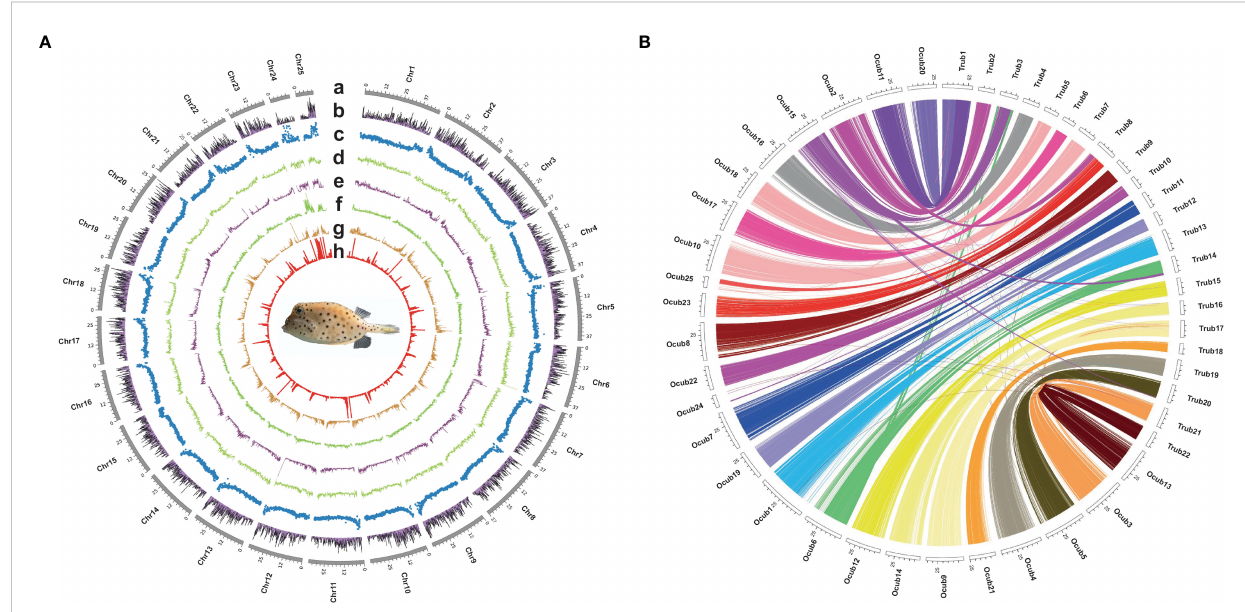
FIGURE 1 Circos plot basic characteristics of O. cubicus and T. rubripes genomes. (A) Circos view of the genome assembly of O. cubicus . (A) Tracks depict a circular representation of haplotype chromosomes in megabases (Mb). (B) GC content, (C) protein-coding genes density, (D – H) repeat sequence density (DNA, LINE, LTR, SINE and TRF, respectively); all statistics use the 100-kb window. (B) Collinear gene blocks between 25 pseudo- chromosomes O. cubicus and 22 chromosomes of T. rubripes